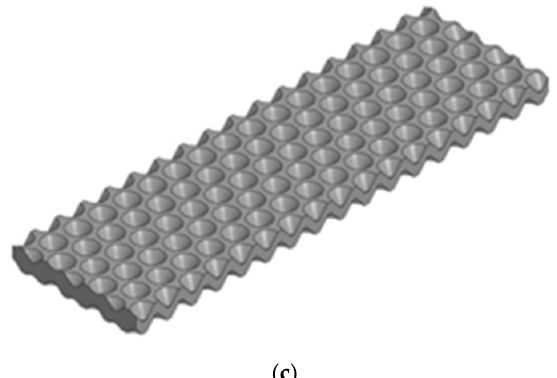
Figure 1. The geometry of the design field of modeling: ( a ) flat heat exchange plate; ( b ) chevron heat exchange plate; ( с ) plate with conical stamping.